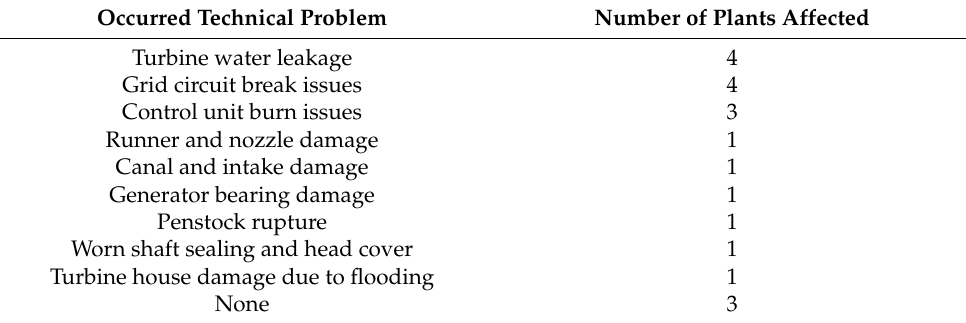
Table 3. Specific technical problems or damages reported to have occurred in 2018 at different power plants. Respondents could specify more than one type of problem. Three respondents answered that there had been no technical problem in the last